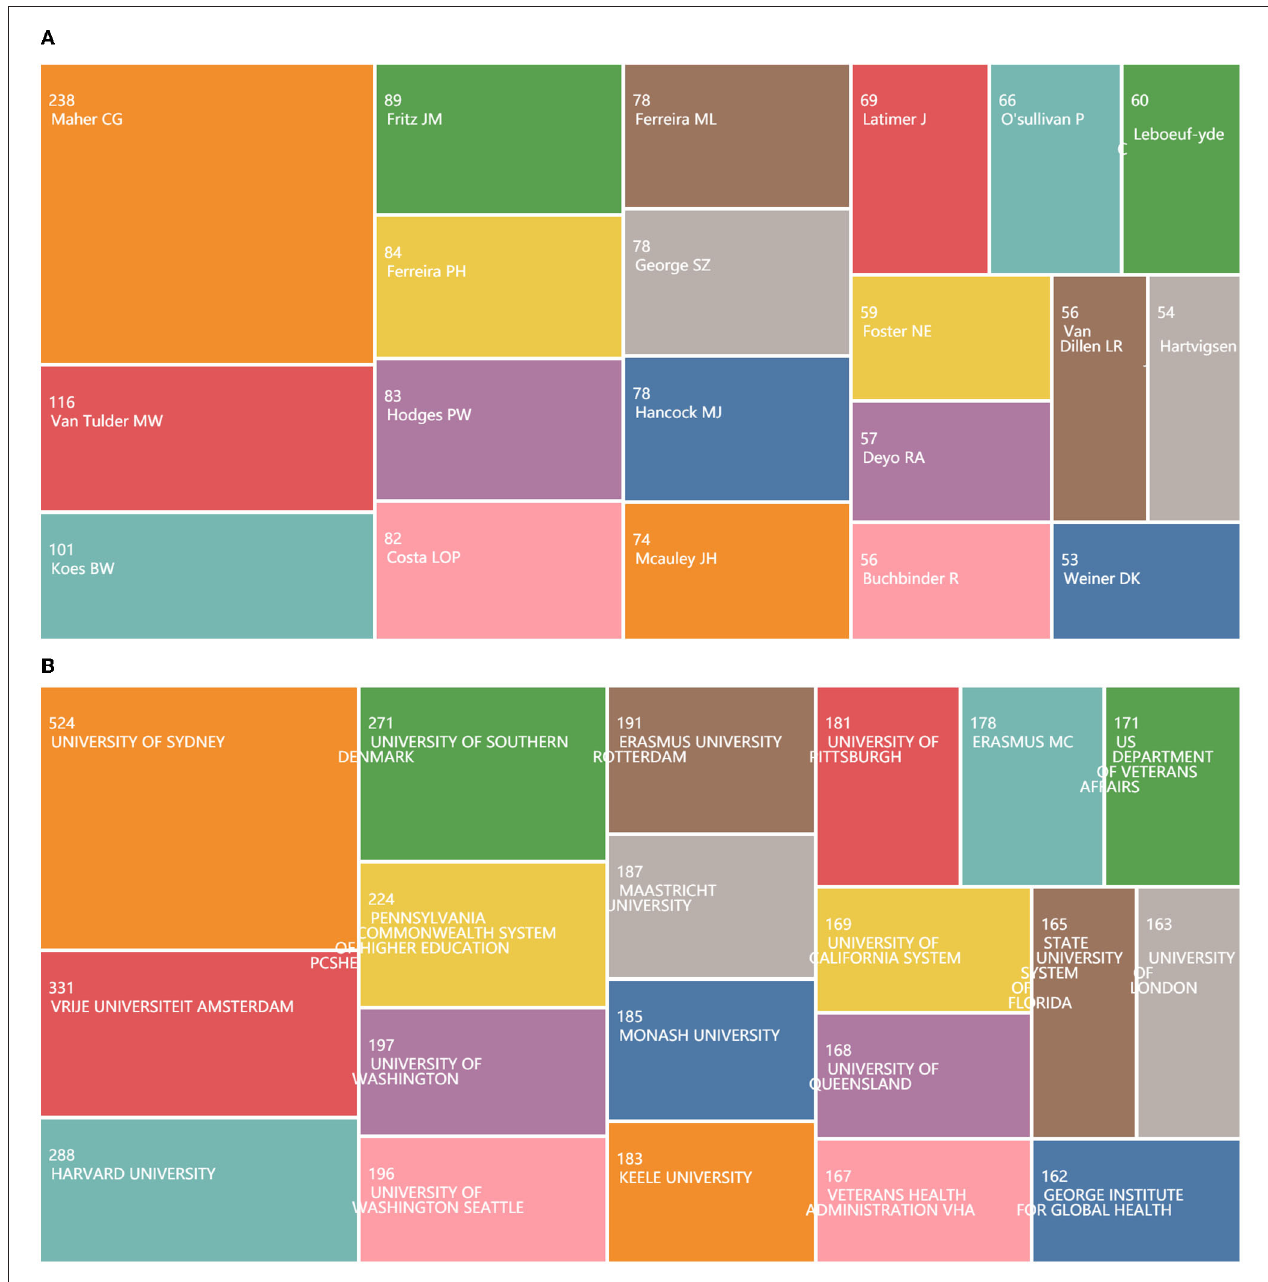
FIGURE 5 | (A) Treemap chart of authors. (B) Treemap chart of institutions.